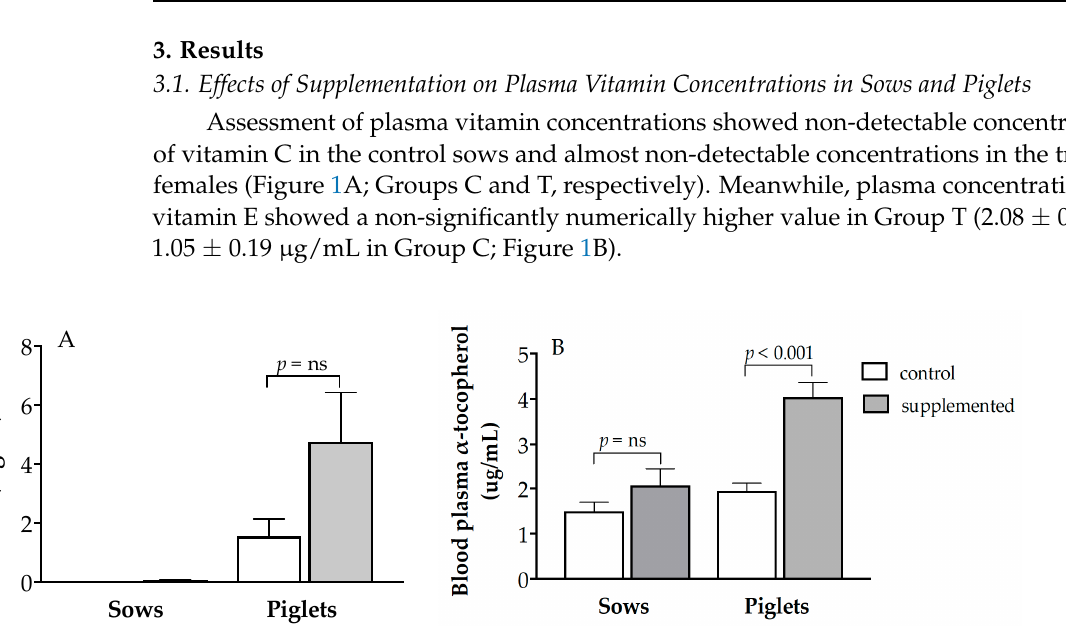
Table 1. Summary of the distribution, by treatment and number of parity, of the pregnancies assessed in the present study.